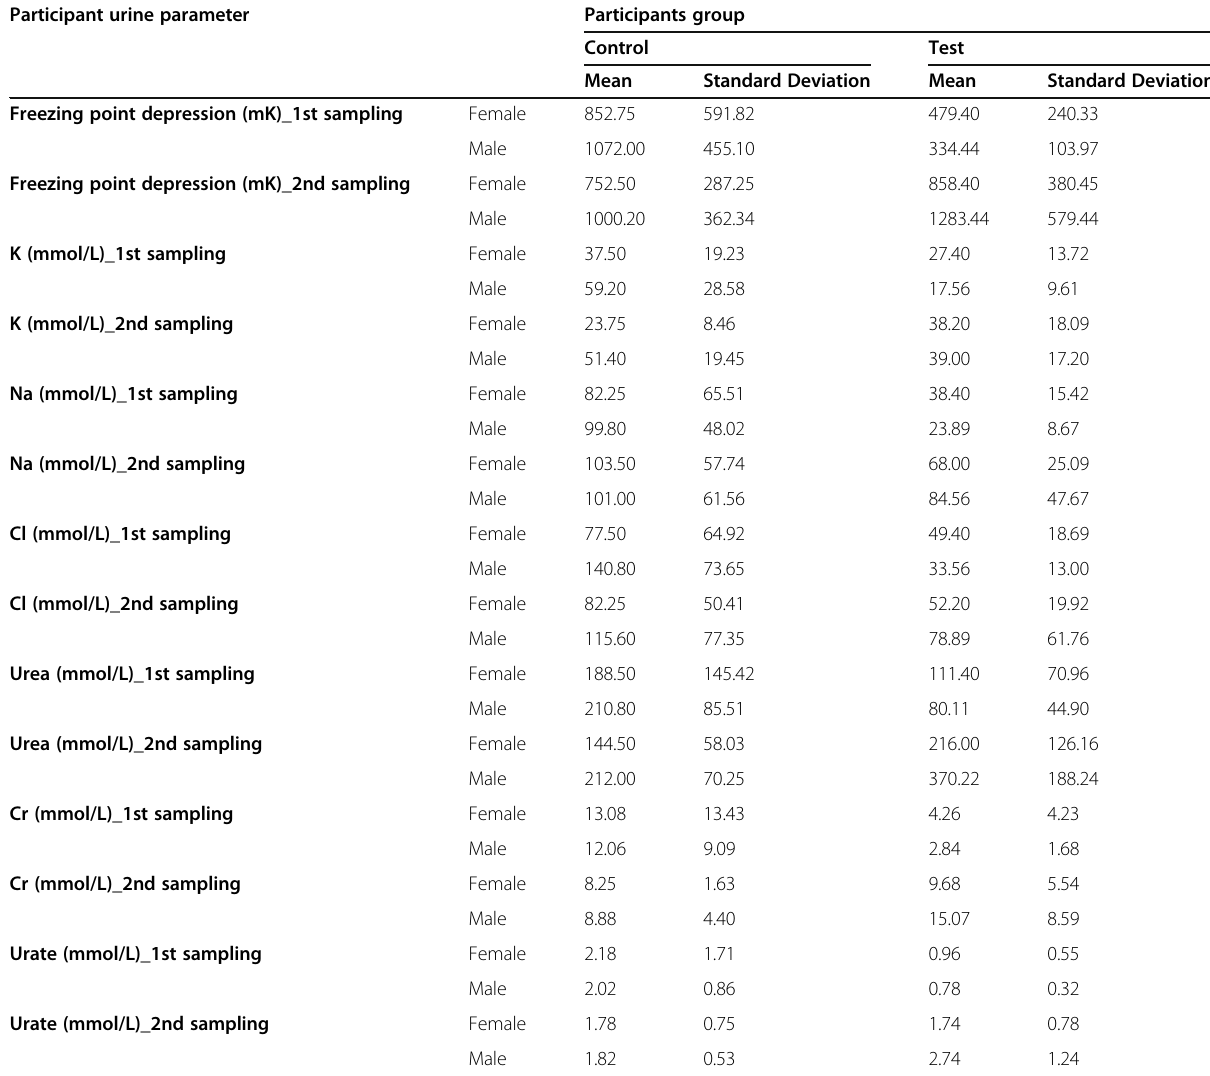
Table 1 Urine parameter value during 1st and 2nd sampling Participant urine parameter Participants